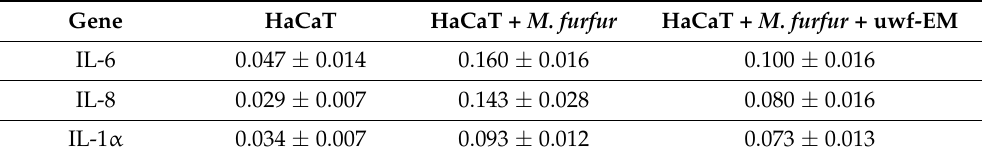
of three replicates along with the corresponding standard